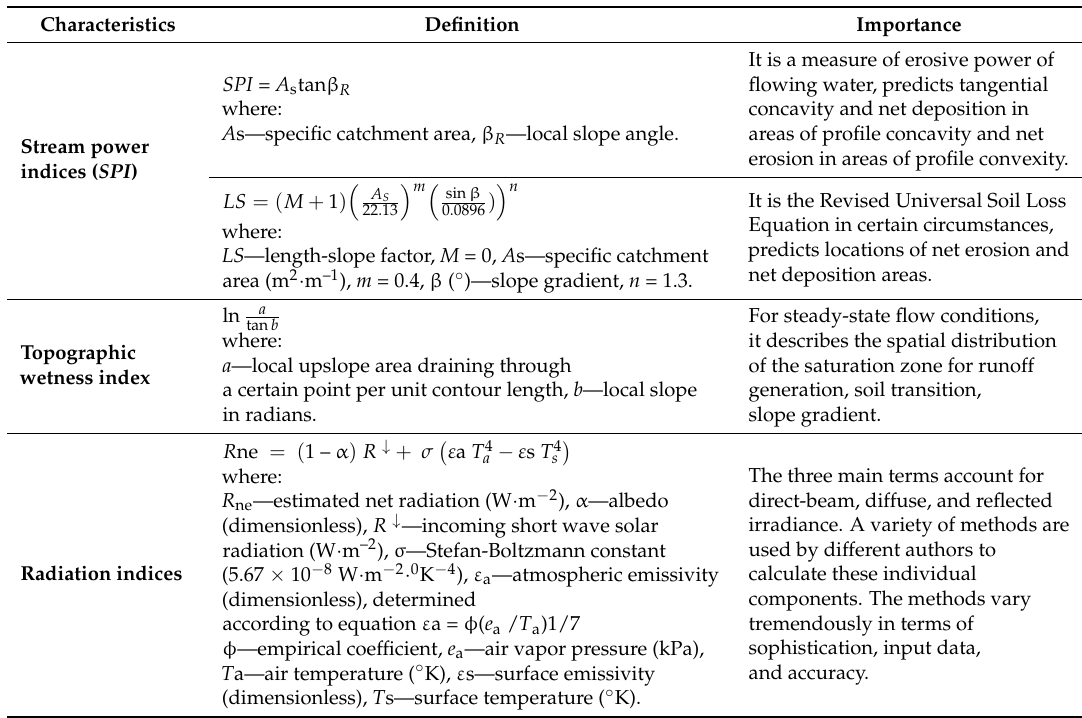
Table 3. Secondary topographic attributes that were computed by terrain analysis from DEM data in this study. Sources: [61–63].